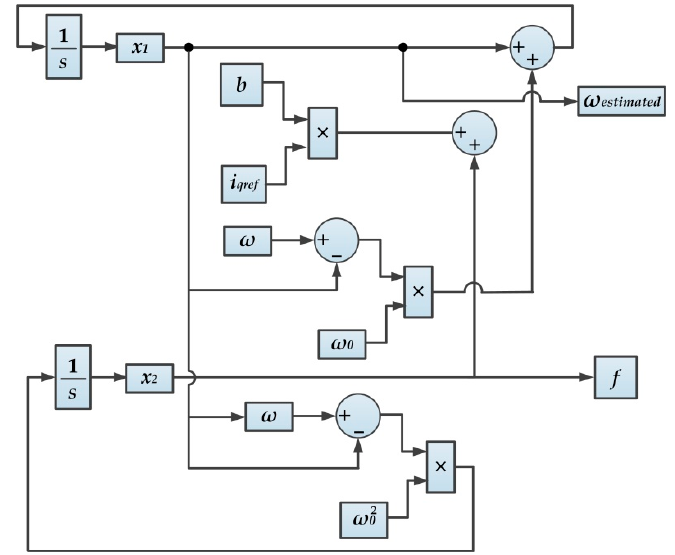
Figure 10. Block diagram for the ESO-type observer.